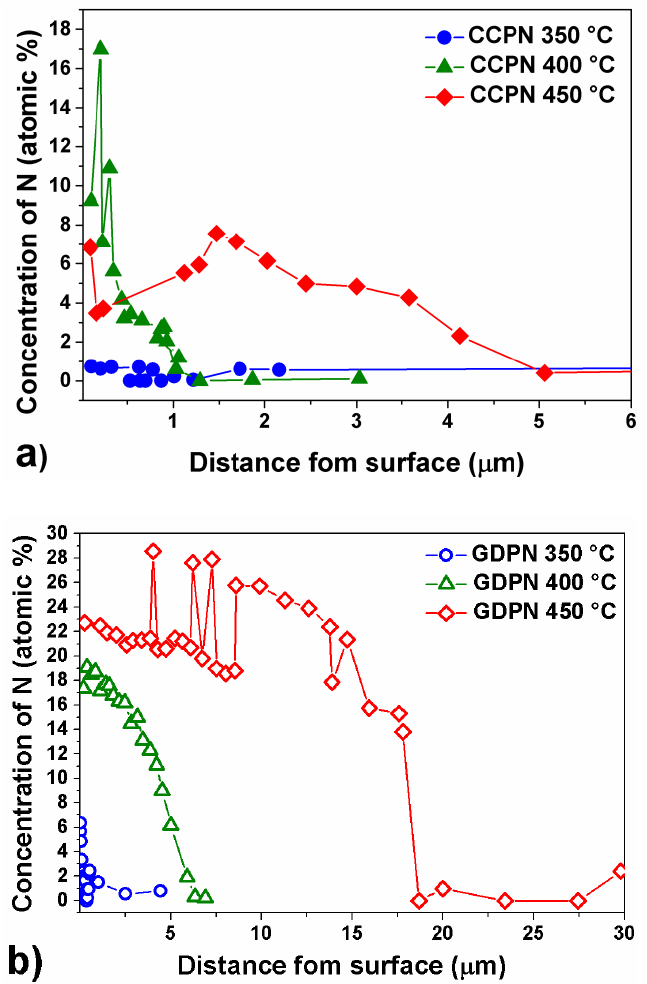
Figure 4. The nitrogen concentration, in at.%, carried out in several points through the cross-section of the ( a ) GDPN- and ( b ) CCPN-treated samples.